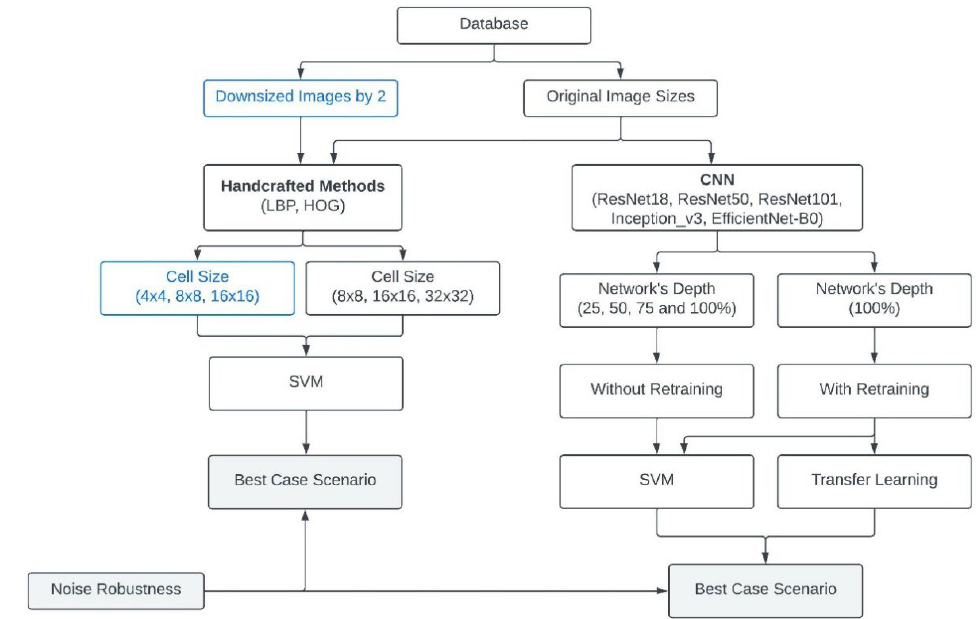
Figure 2. Illustration of the workflow.